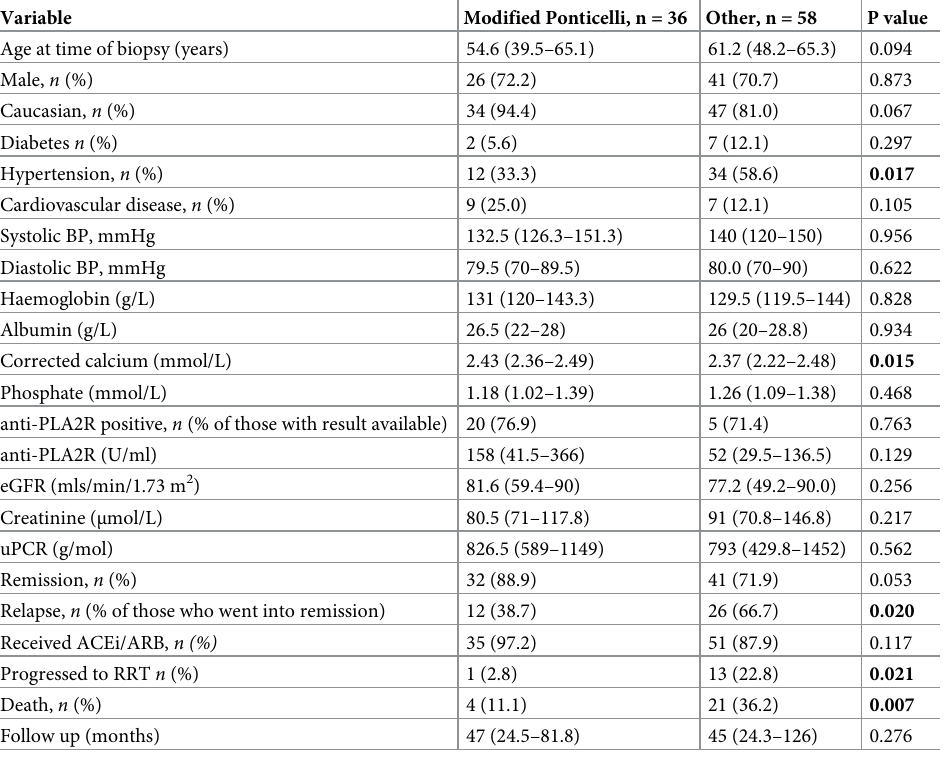
Continuous variables presented as median (interquartile range), p-value by Mann-Whitney U test. Categorical values presented as number (percentage), p-value by Chi-squared test. ACEi, angiotensin converting enzyme inhibitor; ARB, angiotensin receptor blocker; DBP, diastolic blood pressure; eGFR, estimated glomerular filtration rate; MN, membranous nephropathy; anti-PLA2R, anti-phospholipase 2A receptor; RRT, renal replacement therapy; SBP, systolic blood pressure; uPCR, urine protein-creatinine ratio.